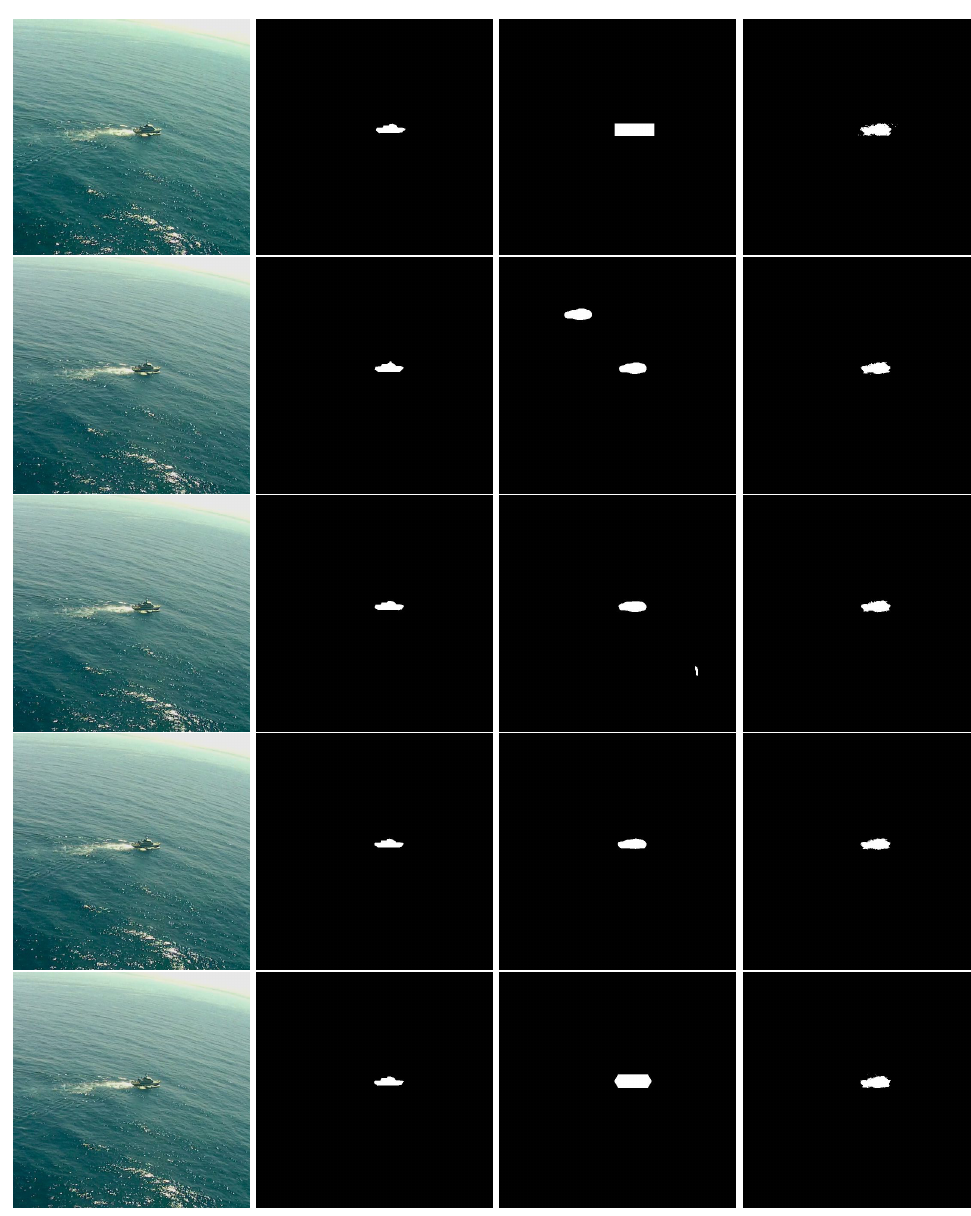
Figure 13. Simulating incorrect Yolact++ segmentations on the Seagull dataset. First rows correspond to older images, while the bottom row corresponds to the most recent image frame. First column: original images; second column: ground-truth annotations; third column: Yolact++ manually disturbed segmented images; fourth column: final segmentation result after post-processing with the 3D